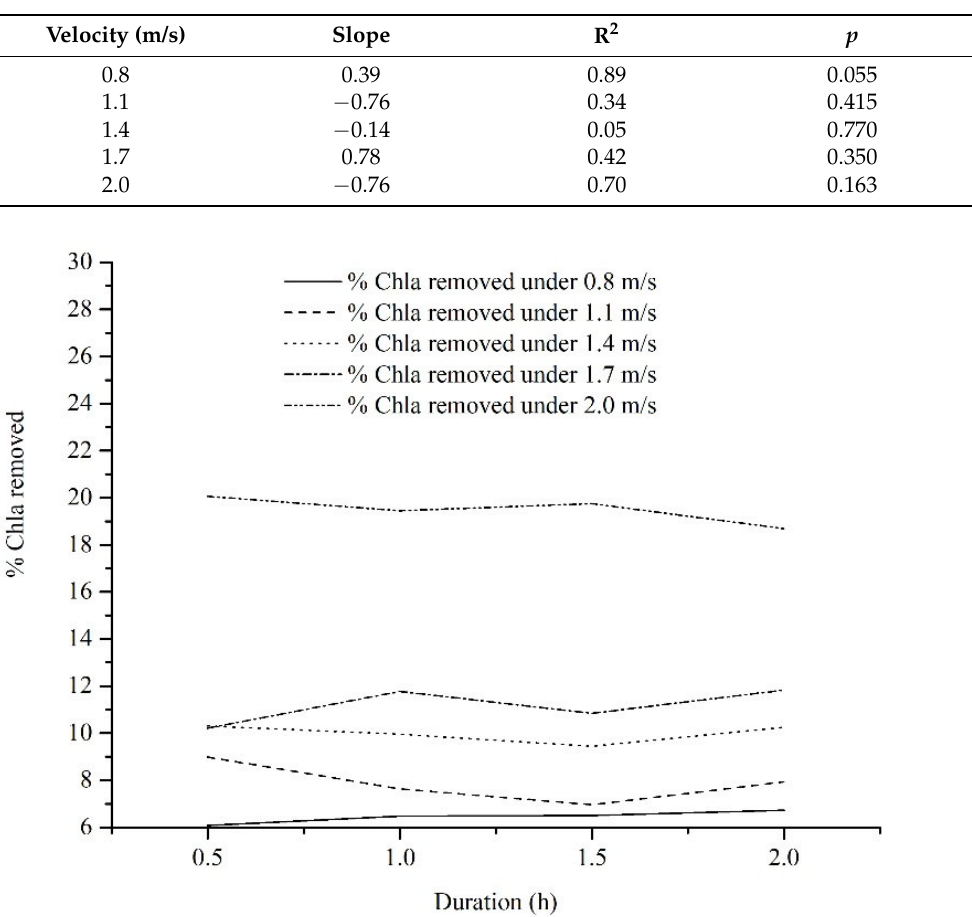
Figure 4. Variation of the biomass removal percentage of benthic algae (% chlorophyll a, mean + SD) as a function of the scouring duration, 0.5, 1.0, 1.5, 2.0 h. The removal percentages show no significant increase with duration.